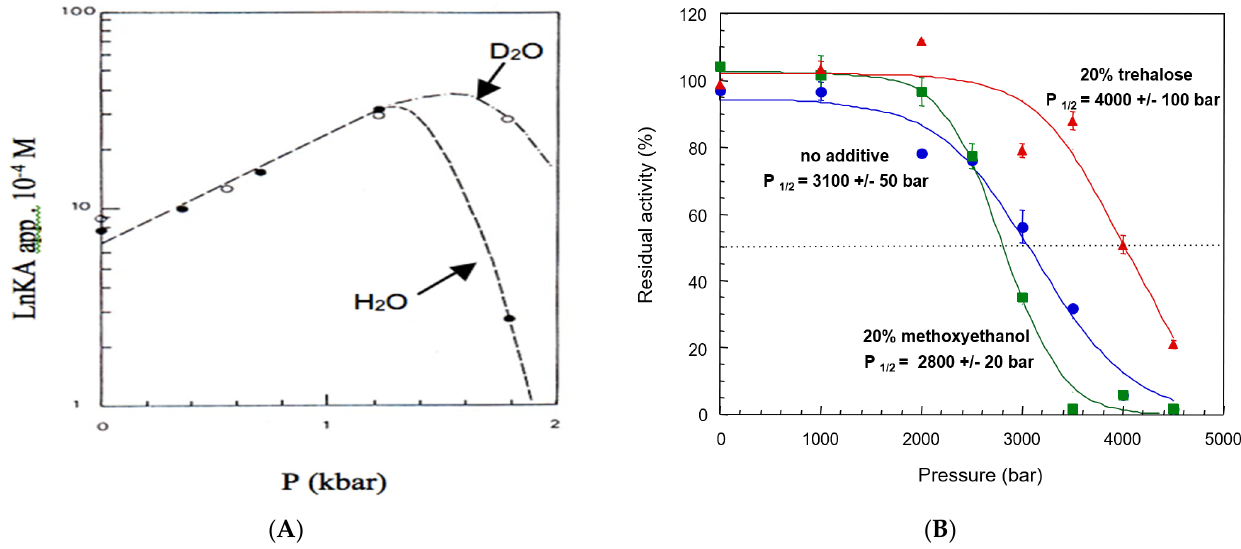
Figure 2. Effect of solvent, cosolvent, and additive on binding affinity ( A ) and catalytic activity ( B ) of human BChE submitted to high pressure. ( A ) Protective effect of D 2 O on pressure-induced loss of affinity for a ligand of human BChE (phenyl-trimethylammonium) in Tris/Gly buffer, pH 8.4 in water or pH 8.8 in 90% D 2 O at 35 °C (redrawn from [26]). ( B ) Loss in activity of human BChE in 10 mM Tris/HCl, pH 7.4 at 25 °C, as a function of hydrostatic pressure in the absence of a cosolvent (blue curve), in the presence of a stabilizer additive (red curve), and in the presence of a destabilizing cosolvent (green curve). Cosolvent (20% v / v ) and stabilizer (20% w / v ) lead to shifts in P 1/2 , the pressure causing 50% of enzyme inactivation (unpublished).